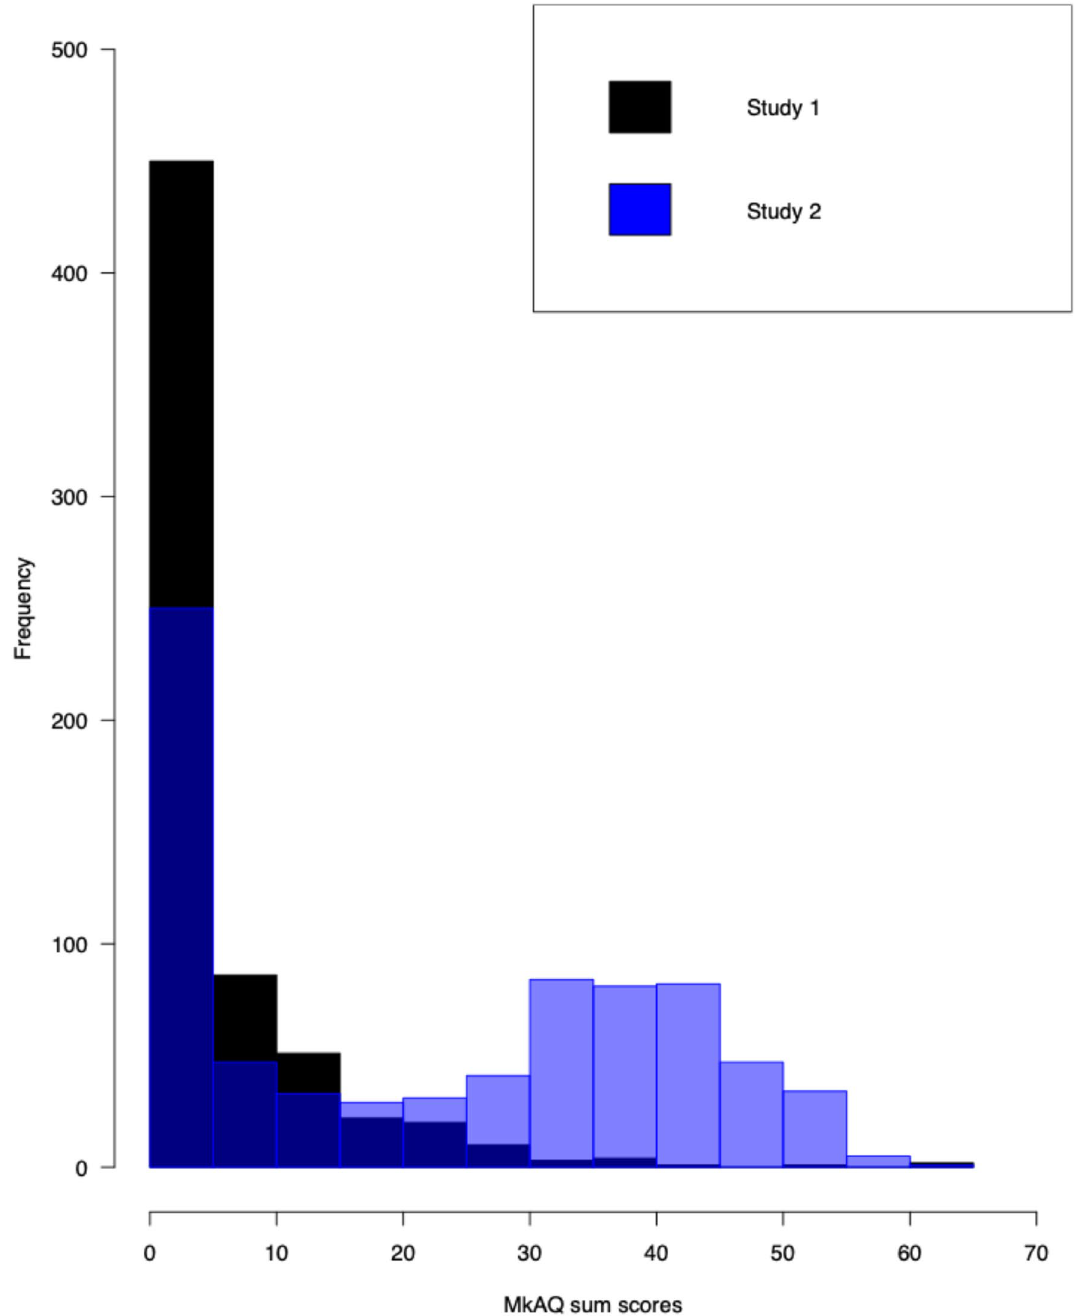
Figure 4. Frequencies of MkAQ sum scores plotted for Study 1 (black) and Study 2